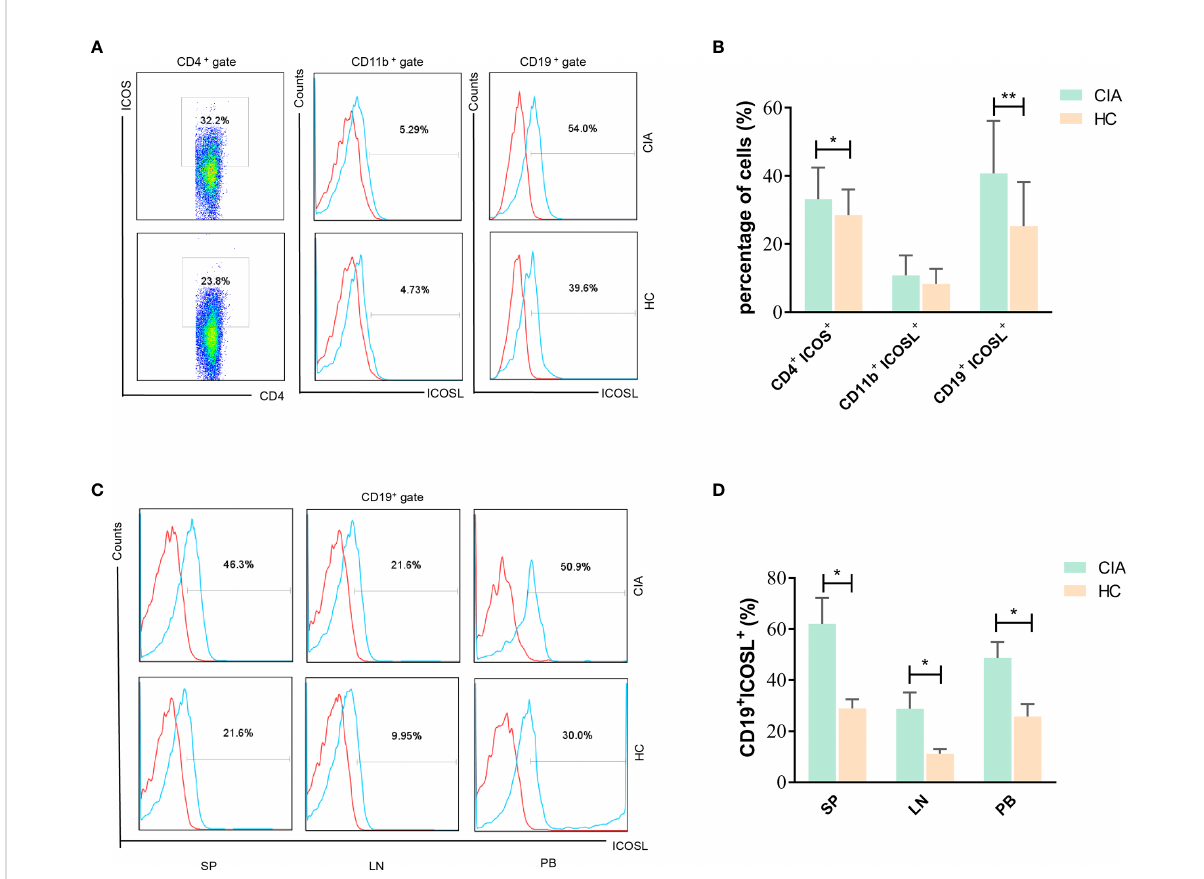
FIGURE 3 Expression of ICOS and ICOSL in CIA mice. (A) The expression of ICOS and ICOSL in spleen samples of CIA mice by fl ow cytometry. (B) Percentages of CD4 + ICOS + , CD11b + ICOSL + and CD19 + ICOSL + cells in spleen samples of CIA mice (n = 20) and controls (n = 20). (C) The expression of ICOSL on CD19 + B cells in tissues of CIA mice by fl ow cytometry. (D) Percentages of CD19 + ICOSL + cells in spleen (SP), lymph nodes (LNs) and PB samples of CIA mice. Bars indicate mean ± SD; * P < 0.05, ** P <